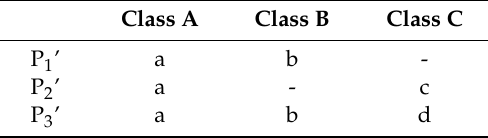
Table 1. Example of checksum matrix.